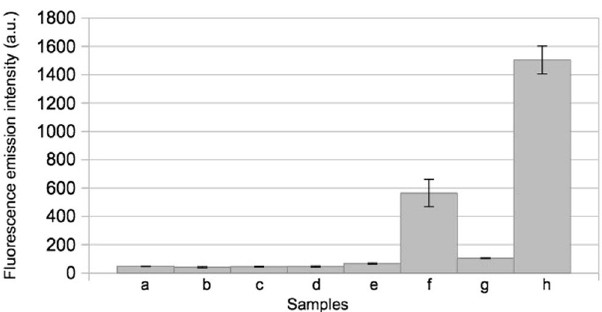
Figure 5. Fluorescence emission intensity (expressed in arbitrary units, a.u.) in 40 mM HEPES pH 7.4, 100 mM KCl, 1 mM MgCl 2 . From left to right: ( a ) background; ( b ) 1 μ M Split1; ( c ) 1 μ M Split2; ( d ) 1 μ M complementary Split1/Split2 DBS; ( e ) 0.5 μ M Split1 and 0.5 μ M Split2; ( f ) 0.5 μ M Split1, 0.5 μ M Split2 and 0.5 μ M complementary Split1/Split2 DBS; ( g ) 1 μ M Split1 and 1 μ M Split2; ( h ) 1 μ M Split1, 1 μ M Split2 and 1 μ M complementary Split1/Split2 DBS (mean ± standard deviation, n = 3). All hybridizations were performed at 37 °C for 25